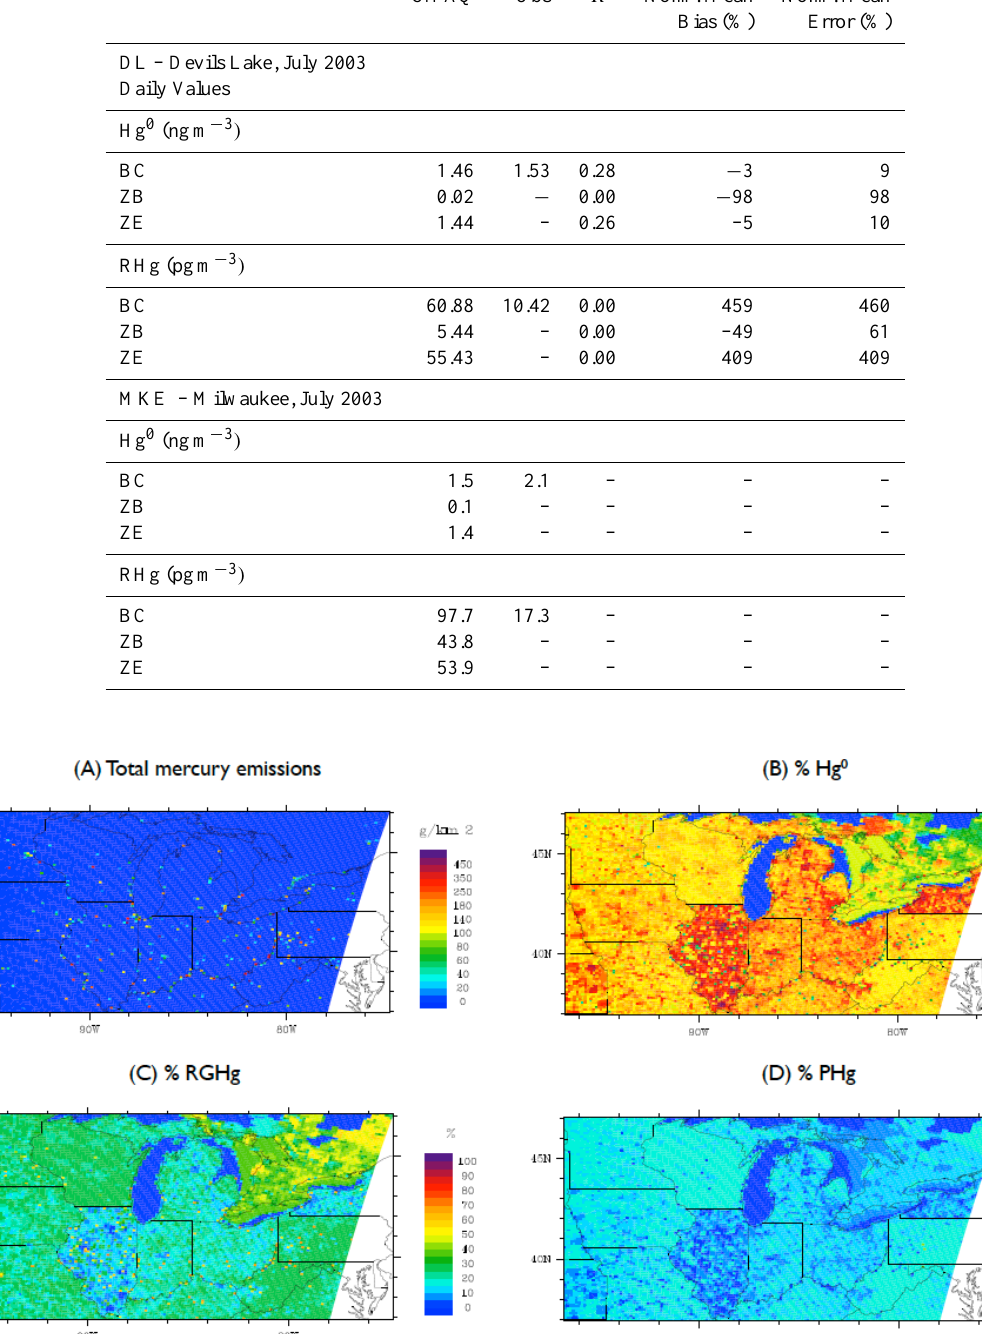
Table 2. Mean values and evaluation metrics are presented to compare sensitivity simulations – BC, ZB, and ZE – of CMAQ-Hg with available measurements of Hg 0 (units ngm − 3 ) , RGHg, PHg, and RHg ( = RGHg + PHg, units pgm − 3 ) at DL and MKE. Equations (1) and (2) used to calculate normalized mean bias and error. All model and DL measurement data from July 2003; measurement data at MKE from July 2004. Norm. Mean